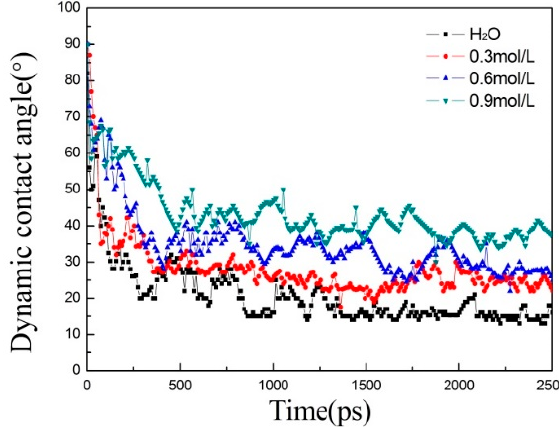
Figure 3. The evolution of dynamic contact angle of the solution with simulation time.